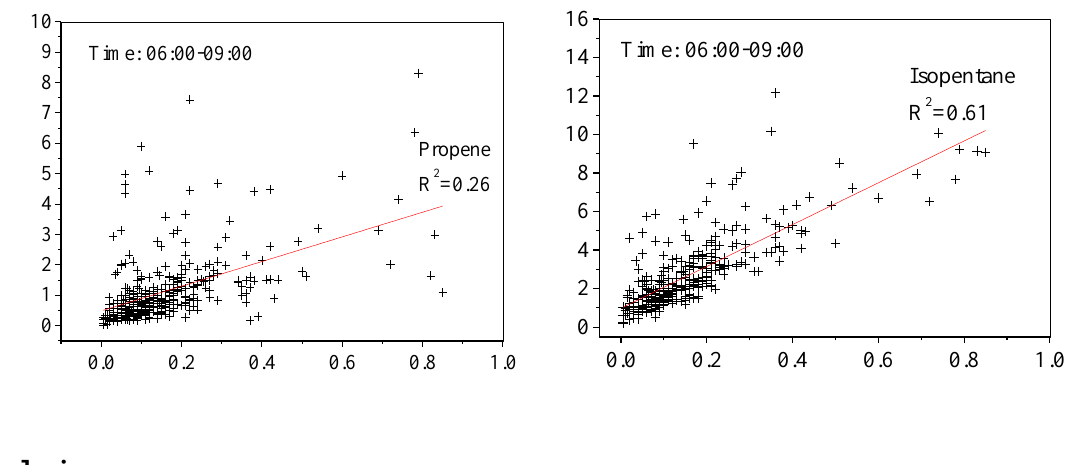
Figure 11. Correlations between isoprene (ppbv) and propene/isopentane (ppbv) in the morning (06:00–09:00) at the Xujiahui